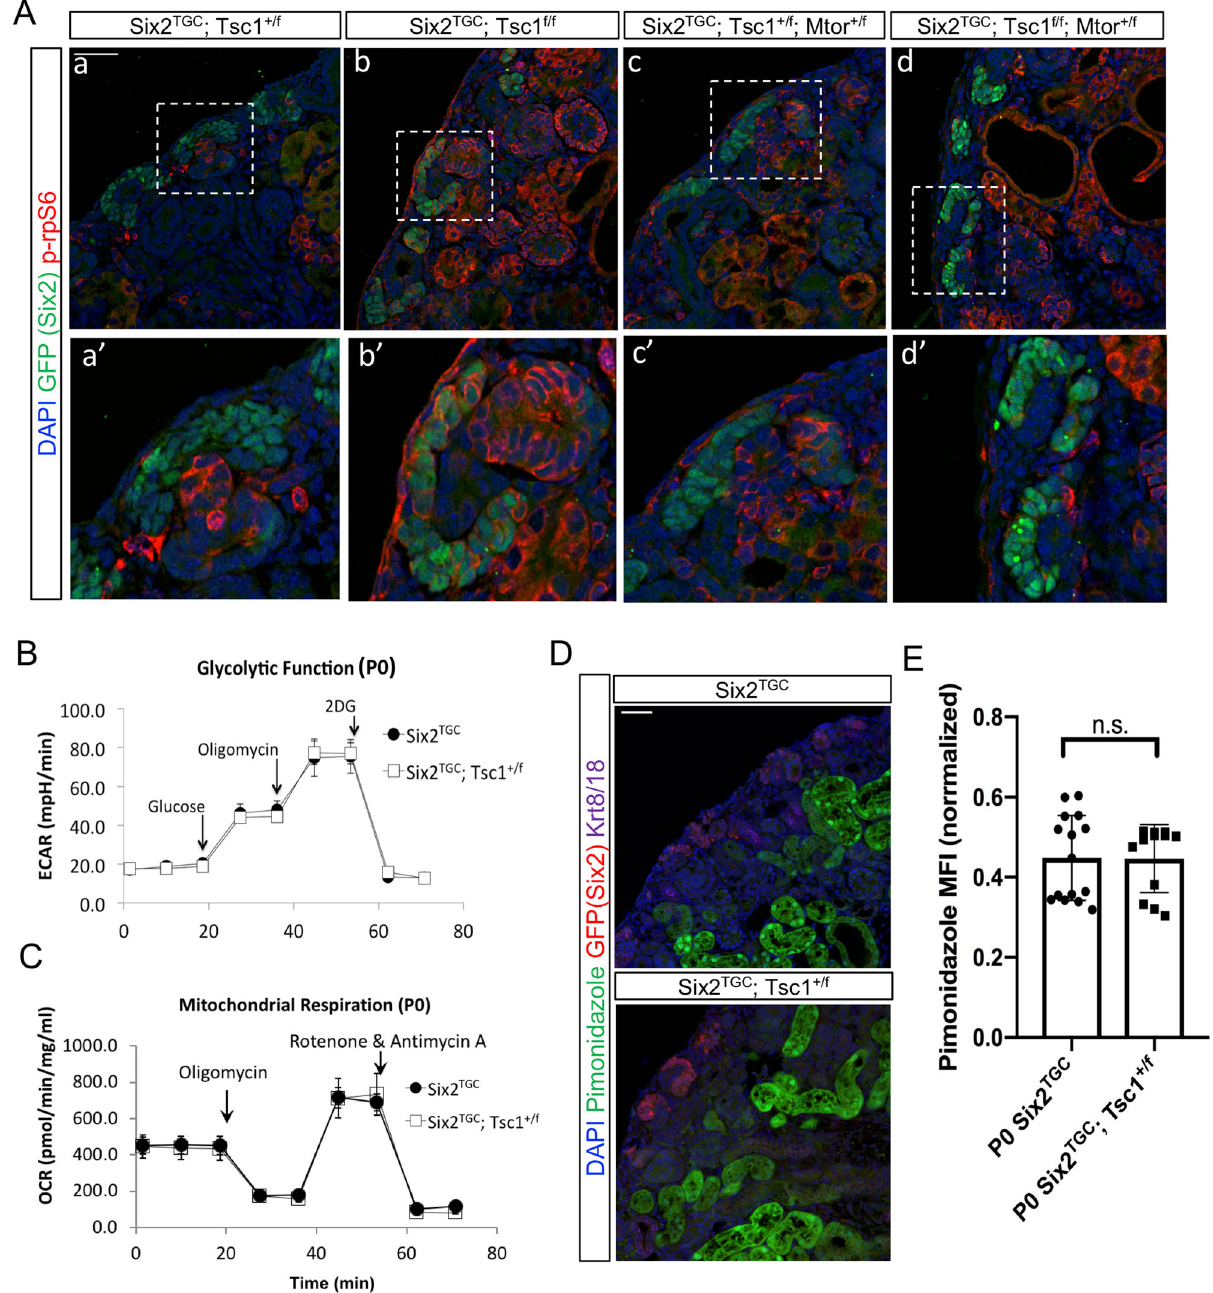
Fig. 3 Evaluation of metabolic contributions to the enhanced nephrogenic phenotype in Six2 TGC;Tsc1 . A Immuno fl uorescence staining for the phosphorylated ribosomal protein S6 (p-rpS6, red) at P0 to assess mTorc1 activity in Tsc1 hemi- and homozygous NPC. Genotype noted on the top, key to antibody staining on the left. Scale bar denotes 50 µ m. Magni fi ed view of NPC (green) in the dashed area below each panel. B , C Seahorse analysis of cultured NPCs reveals no change in glycolytic function ( n = 3 control Six2 TGC and n = 3 Six2 TGC;Tsc1 animals) or in mitochondrial respiration ( n = 3 control Six2 TGC and n = 4 Six2 TGC;Tsc1 animals); error bars represent standard deviation from sample group mean. D Representative image of staining by the hypoxia indicator pimonidazole reveals strong staining in the proximal tubules relative to the GFP (Six2) expressing NPCs. Scale bar denotes 50 µ m. E Quanti fi cation of pimonidazole staining intensity in NPC normalized to adjacent tubular regions to control for differences in dose ef fi cacy ( n = 4 littermate animals in sample group; n = 15 control Six2 TGC and n = 12 Six2 TGC;Tsc1 niches measured). Two-tailed unpaired t tests were performed in GraphPad Prism version 8 to evaluate statistical signi fi cance of pimonidazole signal; n.s. denotes not signi fi cant ( p = 0.9613). Error bars represent standard deviation from the mean. Source data are provided as a Source Data fi scRNA-Seq differentially expressed gene (DEG) signature point- detected by CellChat 56 , a package developed to probe signaling ing to a possible contribution of ribosomal constituents, we pathway activity in scRNA-Seq datasets (Supplementary Fig. S4A, hypothesized that age-dependent changes in the signaling envir- B). Given the technical limitations of scRNA-Seq, including dis- onment may be post-transcriptionally regulated. We thus shifted cordance with the protein state of the cell 57 , and the suggestive